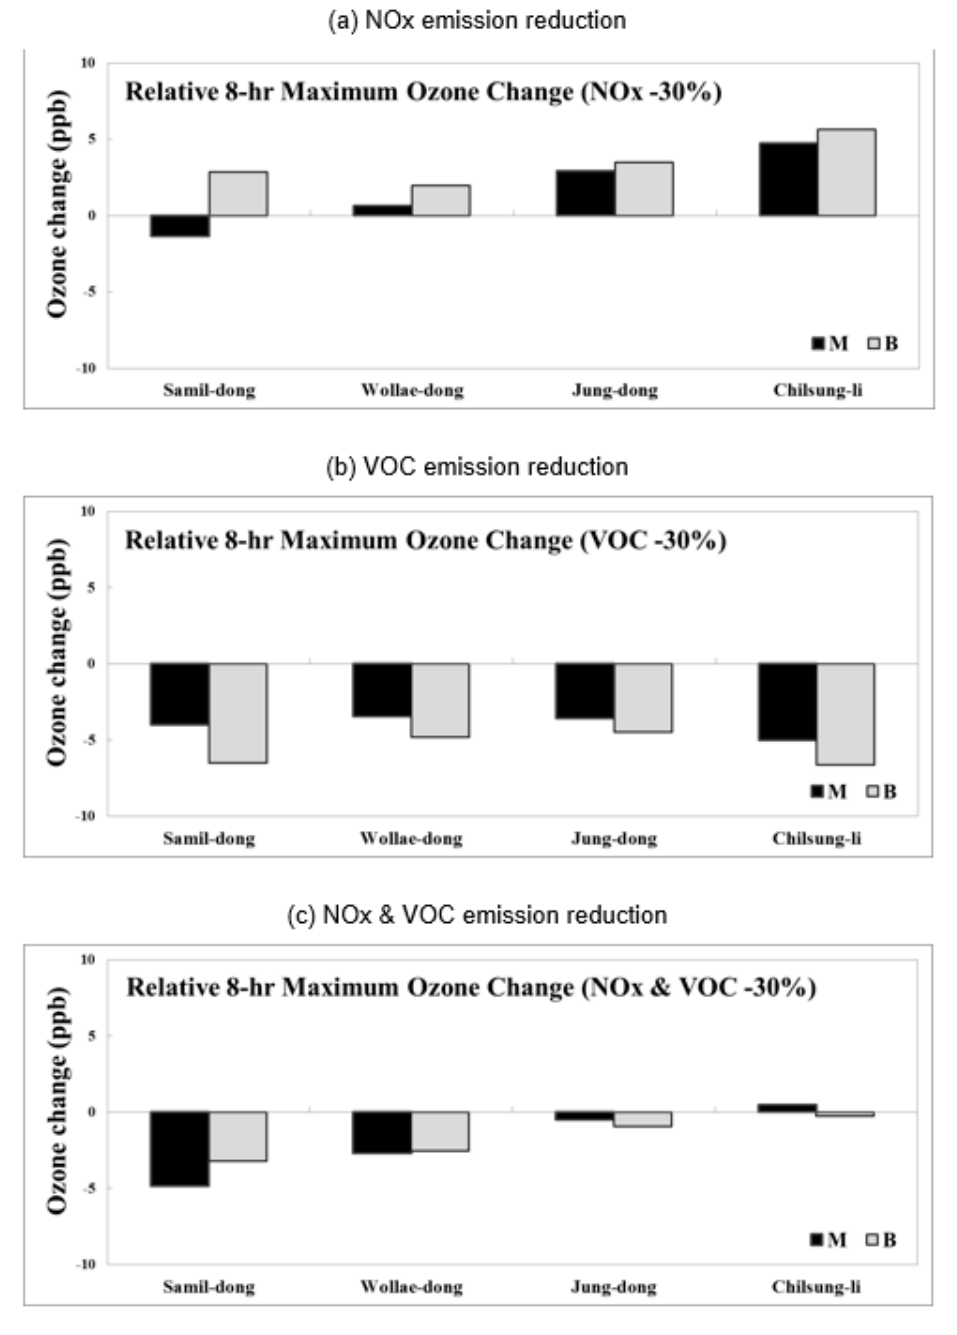
Figure 14. Relative changes in eight-hour maximum ozone because of anthropogenic emissions reduction with MEGAN (black) and BEIS (gray) estimated biogenic emissions: ( a ) 30% NO x reduction, ( b ) 30% VOCs reduction, and ( c ) both 30% NO x and 30% VOCs